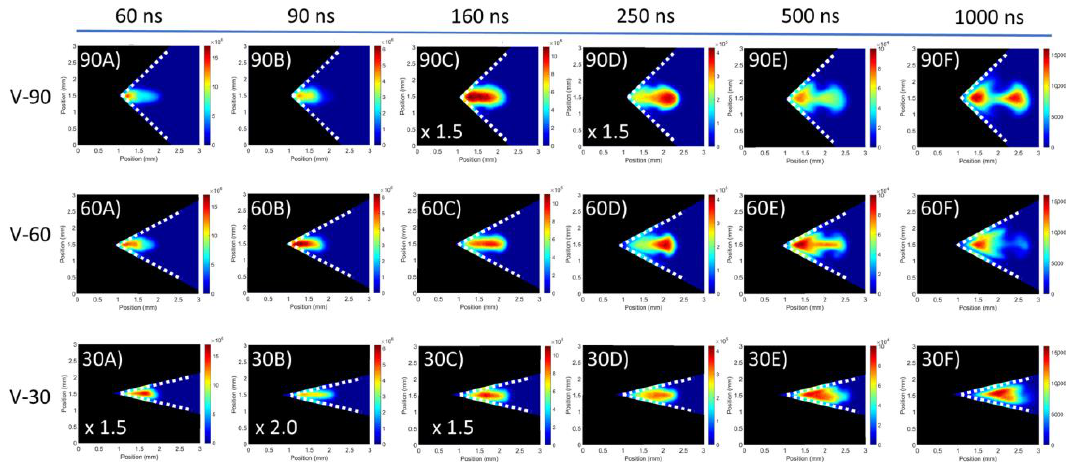
Figure 4. Time-resolved images of the evolution of a laser plasma created on the 90 ◦ V-channel target ( top row ), the 60 ◦ V-channel target ( middle row ) and the 30 ◦ V-channel target ( bottom row ). Image intensities are normalised with multiplicative factors shown on the bottom left where required.